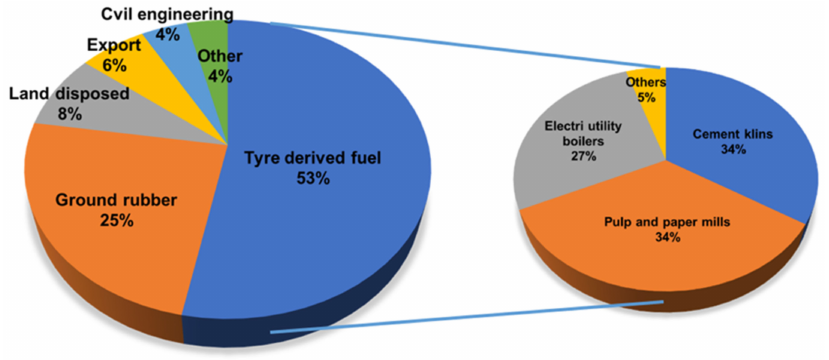
Figure 2. US scrap tyre